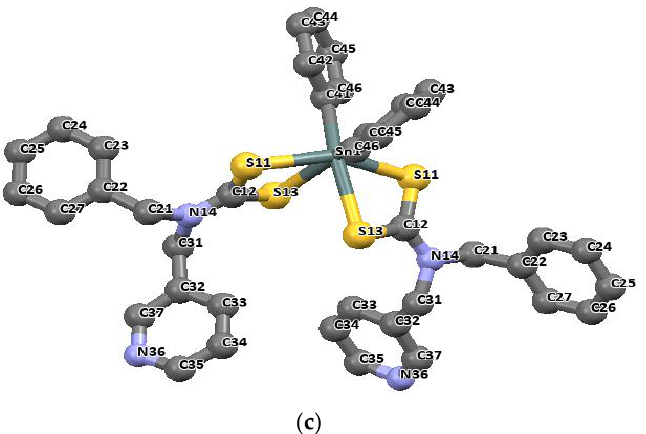
Figure 9. Molecular structures of dibutyltin (IV) 4-phenylpiperazine-1-dithiocarbamate ( a ) [(nBu) 2 Sn(L 1 ) 2 ], dibutyltin(IV) N -benzyl- N -methyl-4-pyridyldithiocarbamate ( b ) [(nBu) 2 Sn(L 2 ) 2 ] and diphenyltin(IV) N -benzyl- N -methyl-3-pyridyldithiocarbamate ( c ) [(Ph) 2 Sn(L 3 ) 2 ], the atom numbering scheme (all hydrogen atoms are omitted for clarity). Redrawn from [26], with permission from Elsevier (Copyright 2018).